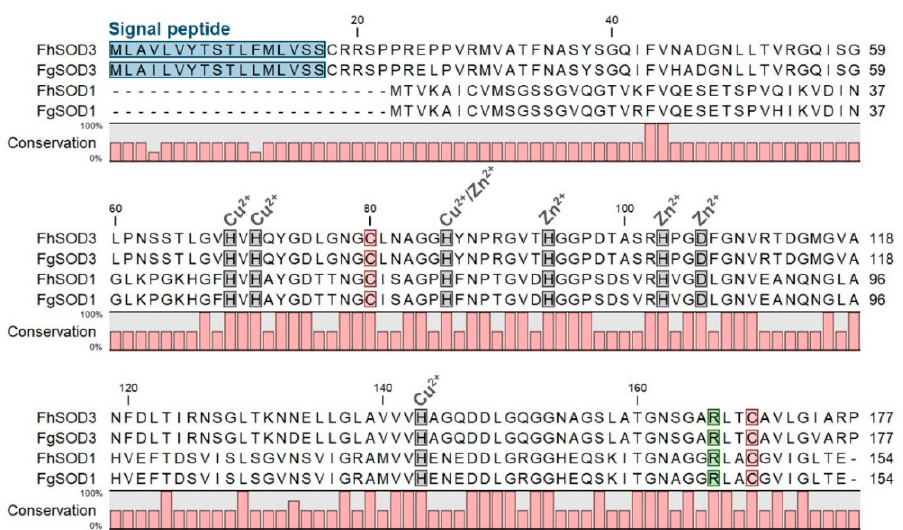
Figure 1. Comparative analysis of F. hepatica and F. gigantica SOD1 and SOD3 amino acid sequences. Metal binding sites are highlighted in grey and predicted signal peptides in blue. The arginine residue responsible for guiding the superoxide anion into the active site is indicated in green and the cysteine residues involved in disulphide bond formation are shown in red. Gaps are indicated by dashes. Amino acid conservation is shown below the alignment.